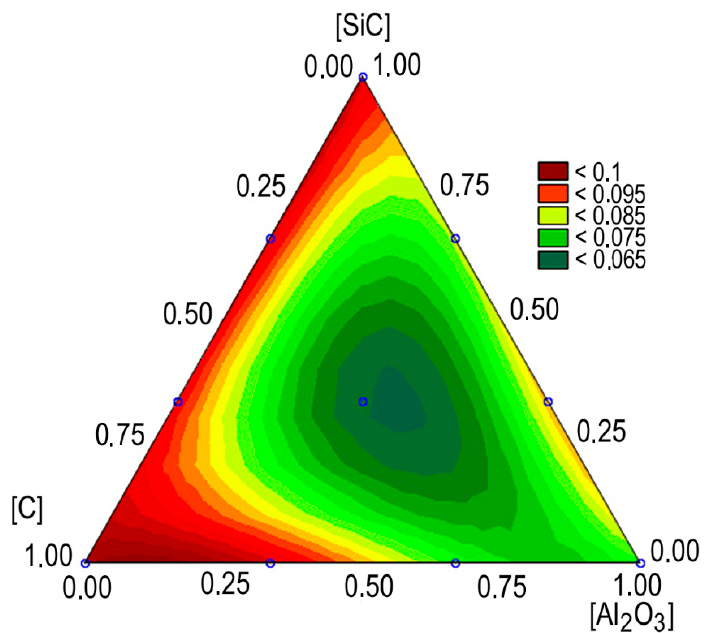
Figure 13. The e ff ect of the MMC composition on the momentary coe ffi cient of Figure 13. The effect of the MMC composition on the momentary coefficient of friction.